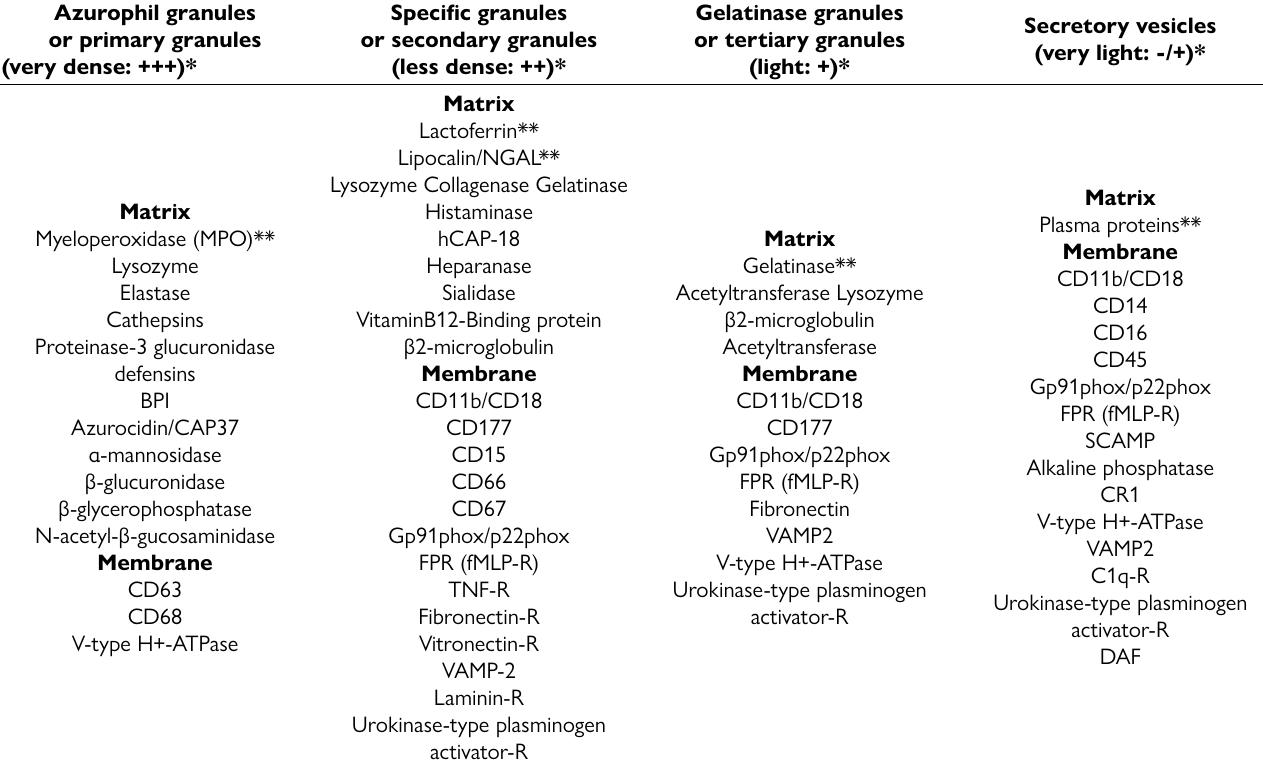
Table 1. Different human neutrophil granules and their contents [29, 30].